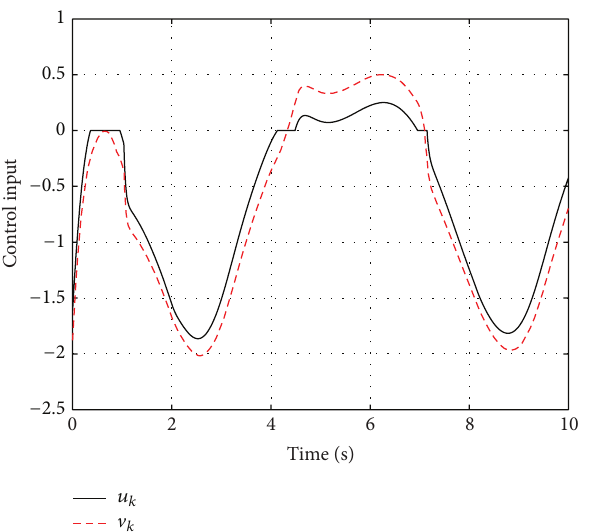
Figure 4: Control input 𝑢 𝑘 and V 𝑘 (𝑘 = 1) in Case 1.